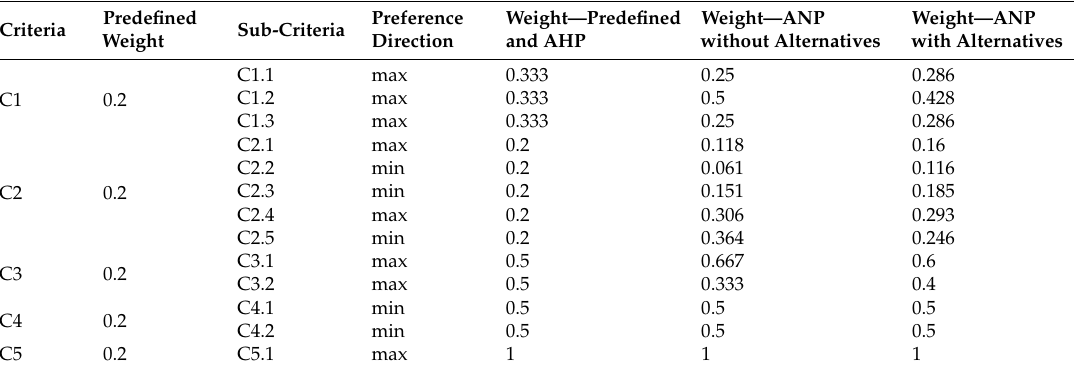
Table 8. Weights of criteria